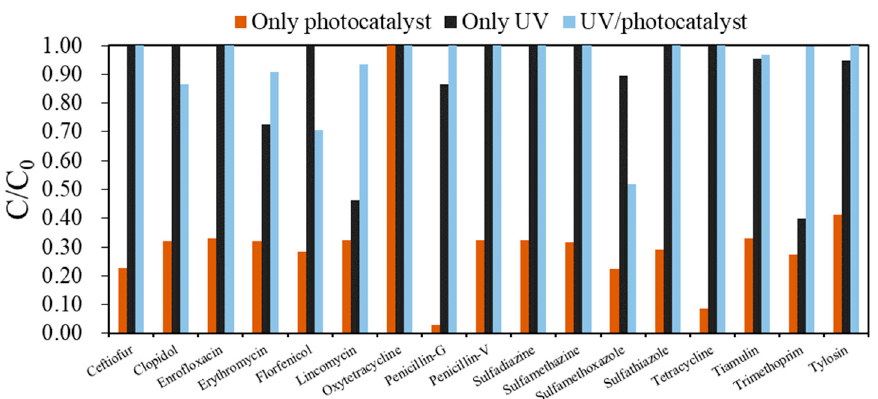
Figure 16. Antibiotic decomposition by using different AOPs, i.e., (i) only UV (ii) only TiO 2 photocatalyst, and UV/TiO 2 photocatalyst.